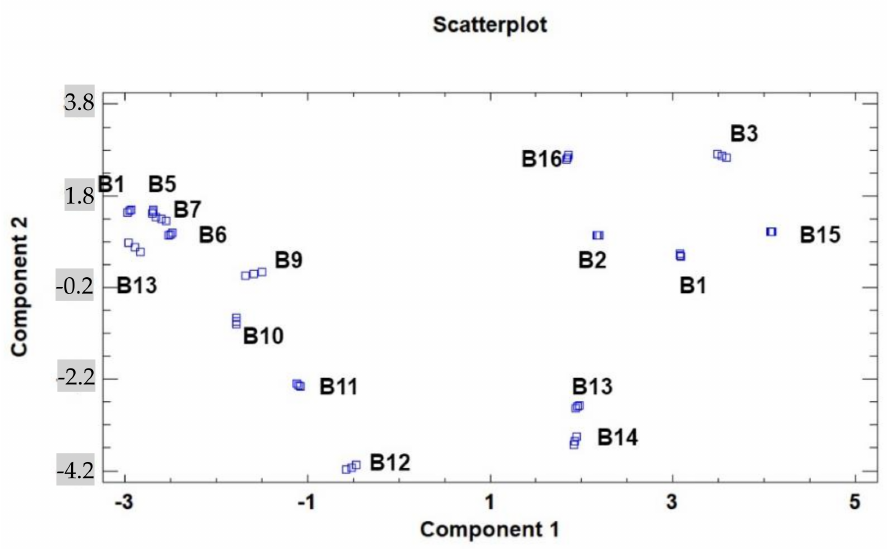
Figure 2. Two-dimensional scatterplot of principal components 1 and 2 for the tested variables at different maturation stages of cardoon blades (samples B1–B16).